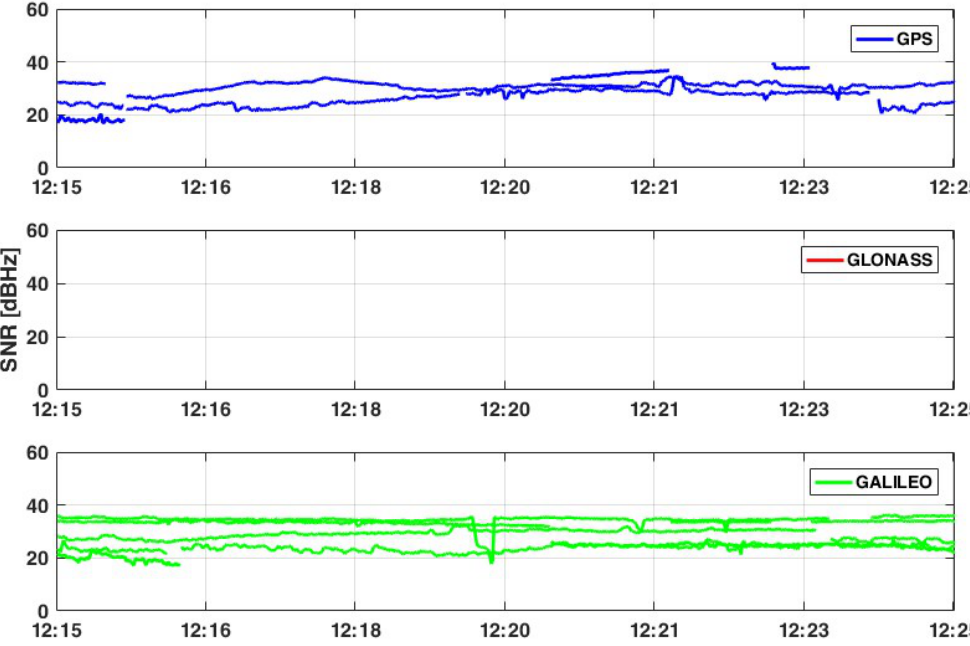
Figure 4. SNR values for tracked satellites - L5 frequency. No GLONASS satellites can track L5 frequency.